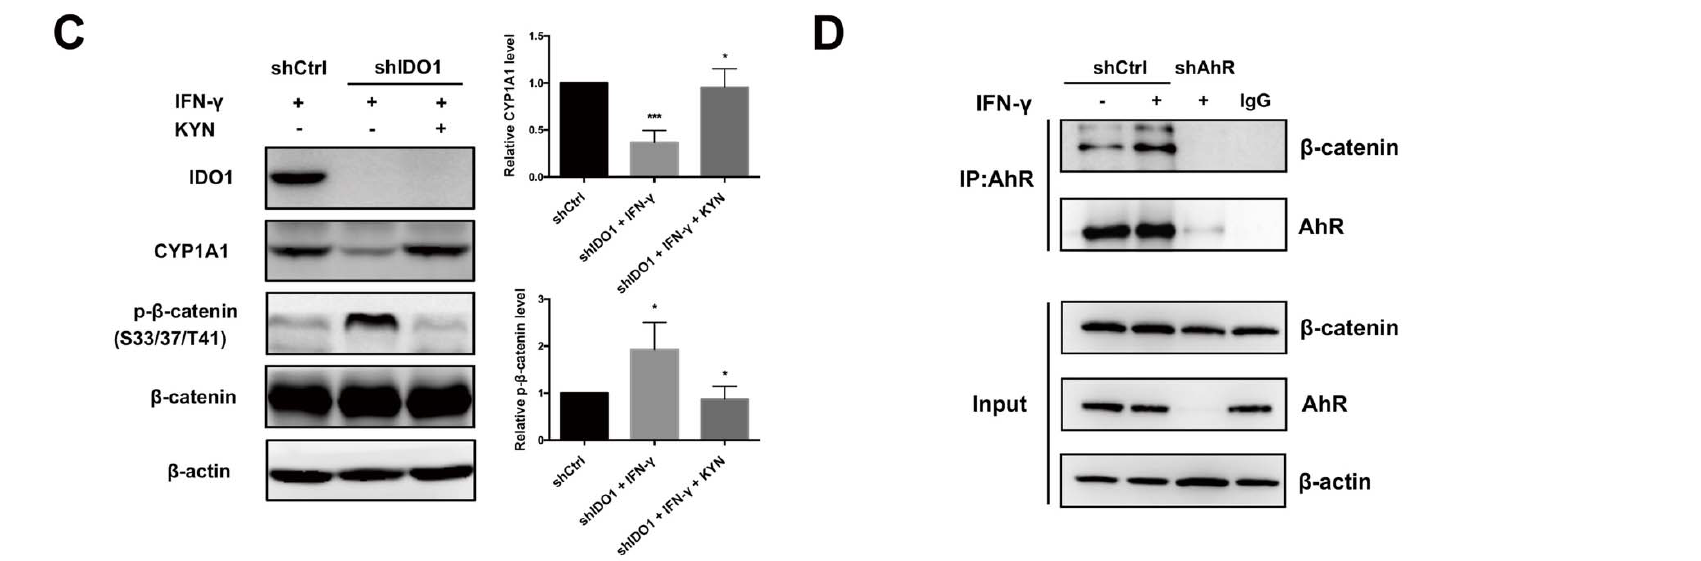
Figure 3. IDO1 activation induces downstream AhR and β -catenin nuclear translocation, activity and mutual interactions. ( A ) Induction of IDO1 simultaneously promoted nuclear translocation of AhR and β -catenin in shCtrl HuH-7 cells. Knockdown of IDO1 impaired nuclear translocation of both molecules in IDO1 knockdown cells, which was rescued by KYN treatment. Control and IDO1 knockdown HuH-7 cells were treated with or without IFN- γ (40 ng/mL) for 48 h in the presence or absence of KYN (100 µ M), and AhR and β -catenin localization were examined via IF staining. Cell nuclei were stained with DAPI (blue), AhR with FITC-labeled antibody (green), and β -catenin with TRITC-labeled antibody (red). Scale bar, 50 µ m ( B ) Nuclear AhR and β -catenin were significantly increased in shCtrl cells under IDO1 activation compared to shIDO1 counterparts. Nuclear translocation of AhR and β -catenin in control and IDO1 knockdown HuH-7 cells with or without KYN (100 µ M) rescue under IFN- γ (40 ng/mL) stimulation for 48 h examined via the cell fractionation assay. Left, fractionated samples were separated via SDS-PAGE and analyzed via immunoblot with the specified antibodies. Right, relative changes in nuclear AhR and β -catenin quantified using Lamin B as a normalization control. ( C ) Induction of IDO1 significantly increased the expression of CYP1A1 and decreased the phosphorylation of β -catenin in shCtrl cells relative to shIDO1 counterparts. Examination of AhR and β -catenin activity under IFN- γ (40 ng/mL) induction in control, shIDO1 or KYN (100 µ M) rescued HuH-7 cell groups by comparing downstream CYP1A1 and p- β -catenin (S33/37/T41) expression via immunoblotting, left. Right, relative changes in CYP1A1 and p- β -catenin quantified using β -actin or β -catenin as normalization control, respectively. ( D ) Activation of IDO1 significantly increased the co-immunoprecipitated β -catenin in shCtrl HuH-7 cells. Interactions of AhR and β -catenin under IDO1 activation via IFN- γ (40 ng/mL) induction, validated using co-immunoprecipitation assay and subsequent immunoblot analyses. All statistical data were calculated from three independent replicates (shCtrl, control shRNA; shIDO1, shRNA against IDO1; shAhR, shRNA against AhR; *, p < 0.05; **, p < 0.01; ***, p <